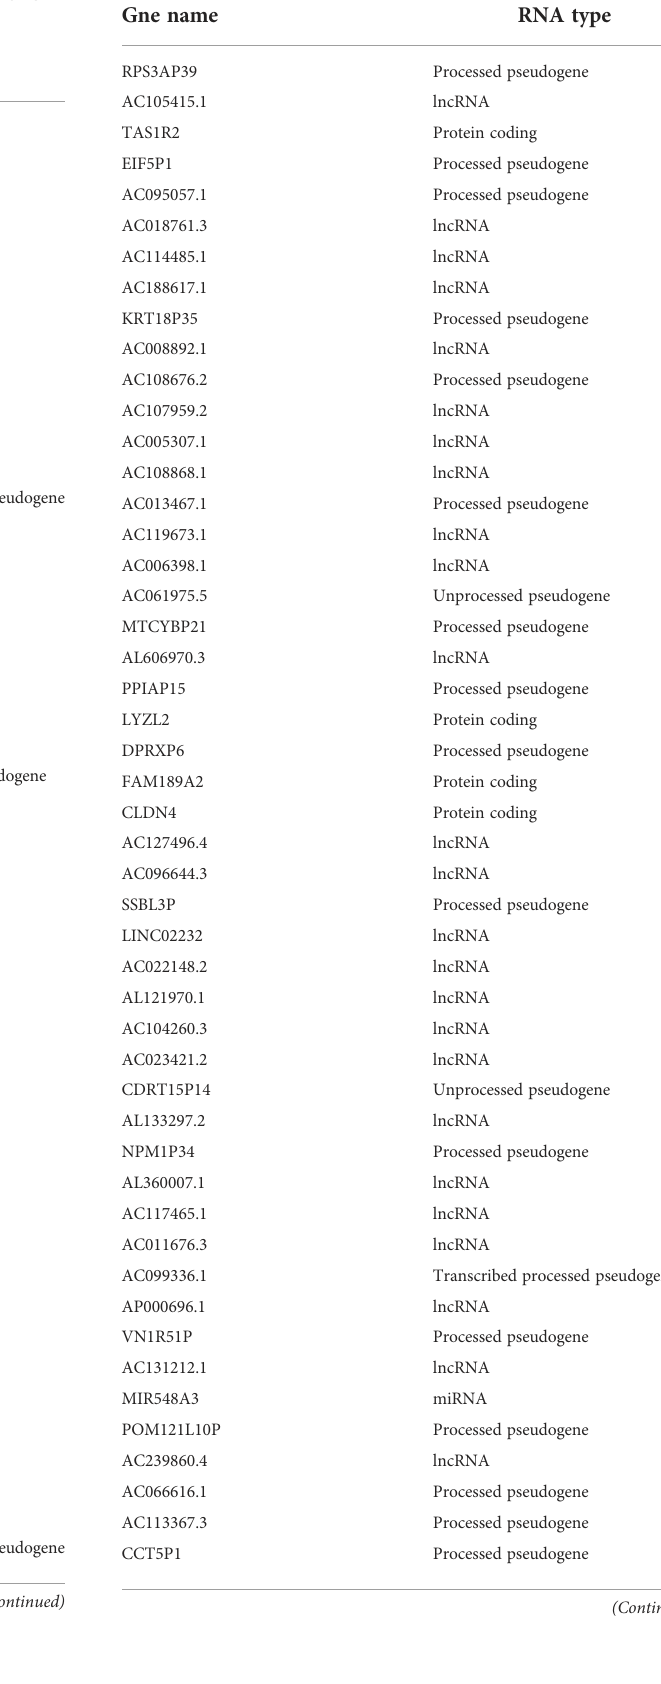
TABLE 1 The 164 common up-regulated genes were identi fi ed in BOT carcinoma vs tongue carcinoma group and BOT carcinoma vs tonsillar carcinoma